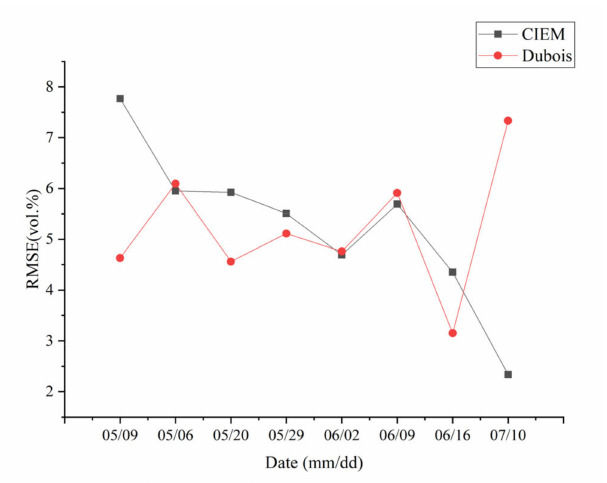
Figure 9. Estimation accuracy of CIEM and Dubois models on different sampling